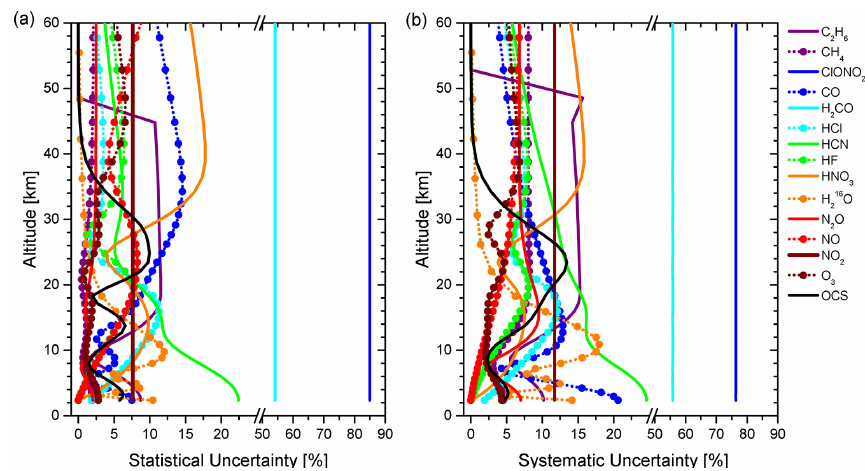
Figure 4. Example of estimated uncertainty profiles for all standard and non-standard NDACC products for typical measurement conditions at IZO (same spectrum as Fig. 3): (a) total errors due to statistical uncertainty sources and (b) total errors due to systematic uncertainty sources. Total errors are computed as the square root of the quadratic sum of all statistical and systematic error sources considered according to Appendix A. Note that for water vapour only the error profiles of the main isotopologue (H 16